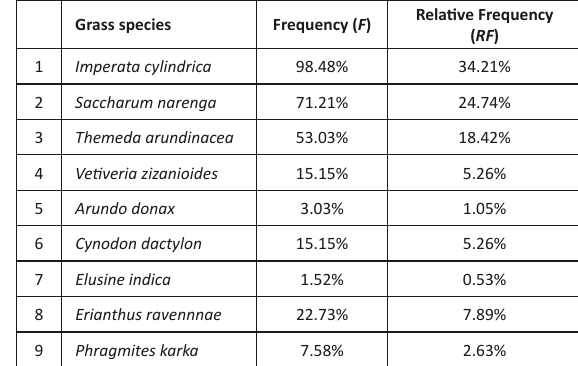
Table 1. Frequency distribution of grass species recorded in the